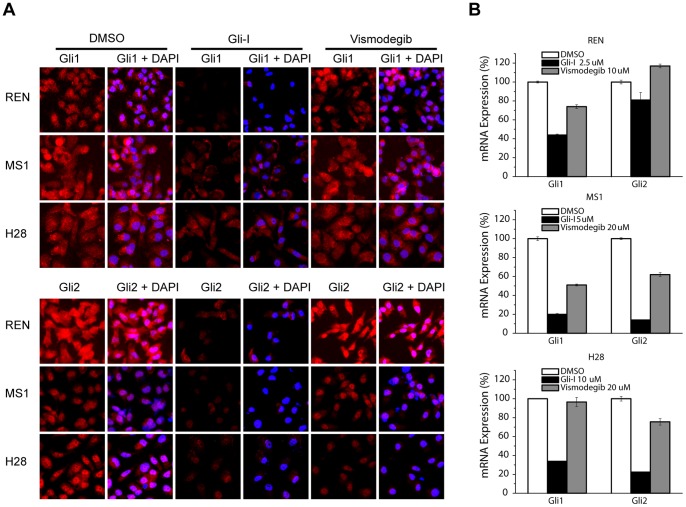
The Gli Inhibitor More Effectively Down-regulated Gli Expression than Vismodegib. A, Immunofluorescence staining of Gli1 and Gli2 upon 48 hr treatment of Gli-I and vismodegib in three MPM cell lines. B, RT-PCR analysis of gli1 and gli2 expression upon 30 hr treatment of Gli-I and vismodegib. The concentrations of both compounds for each cell line were the same in A and B, and were labeled in B.